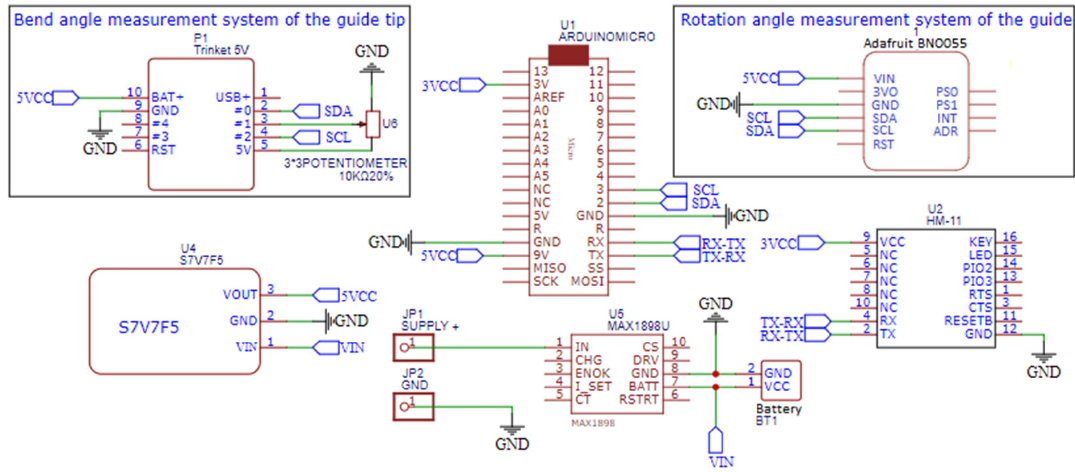
Figure 8. Cordless measurement system circuit of the guide handle rotation angle and the deflection of the guide tip.